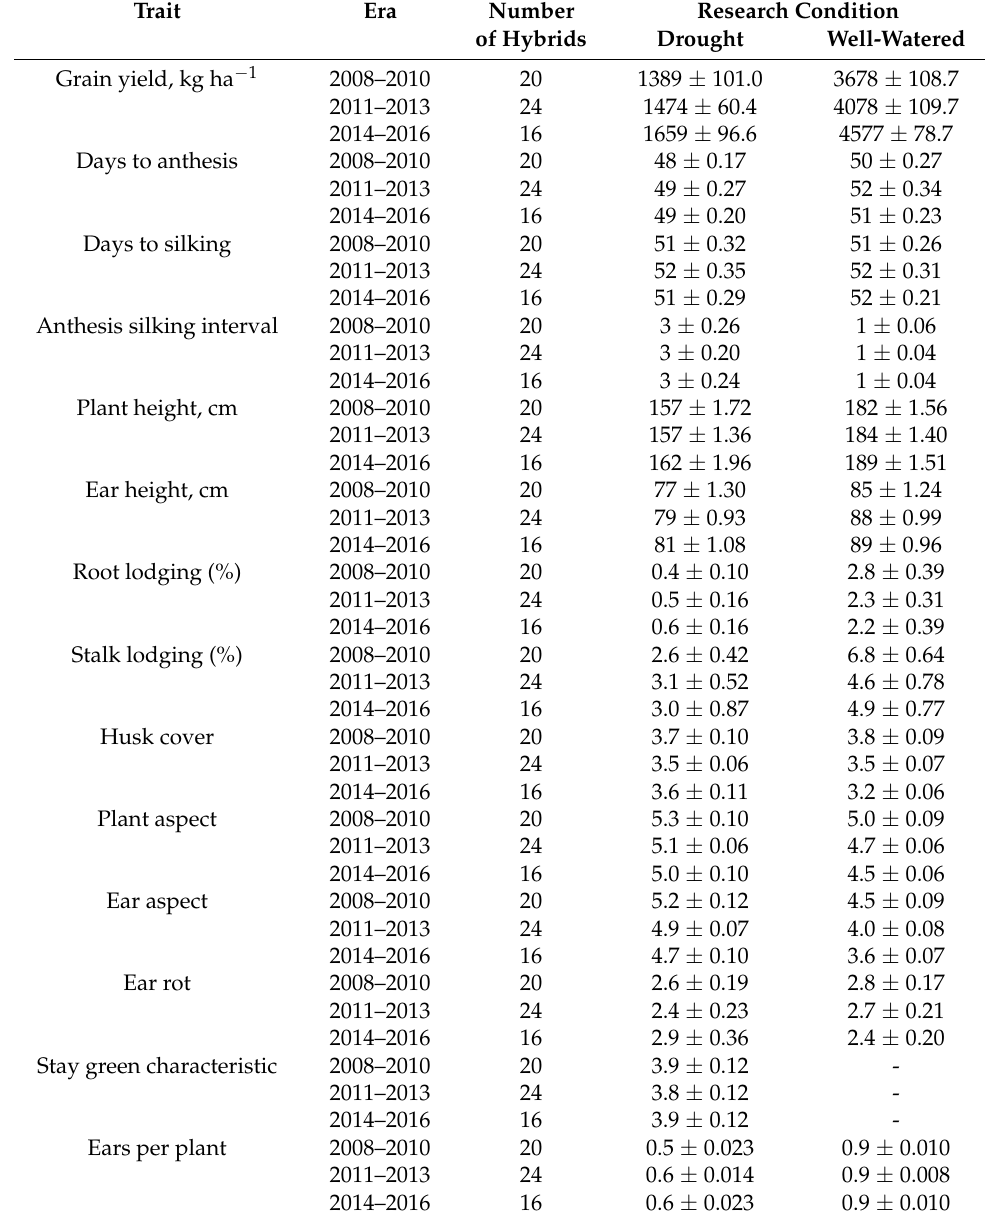
Table 3. Mean grain yield and other agronomic traits of extra-early maize hybrids of three breeding periods assessed under drought at Ikenne during 2016–2019 dry